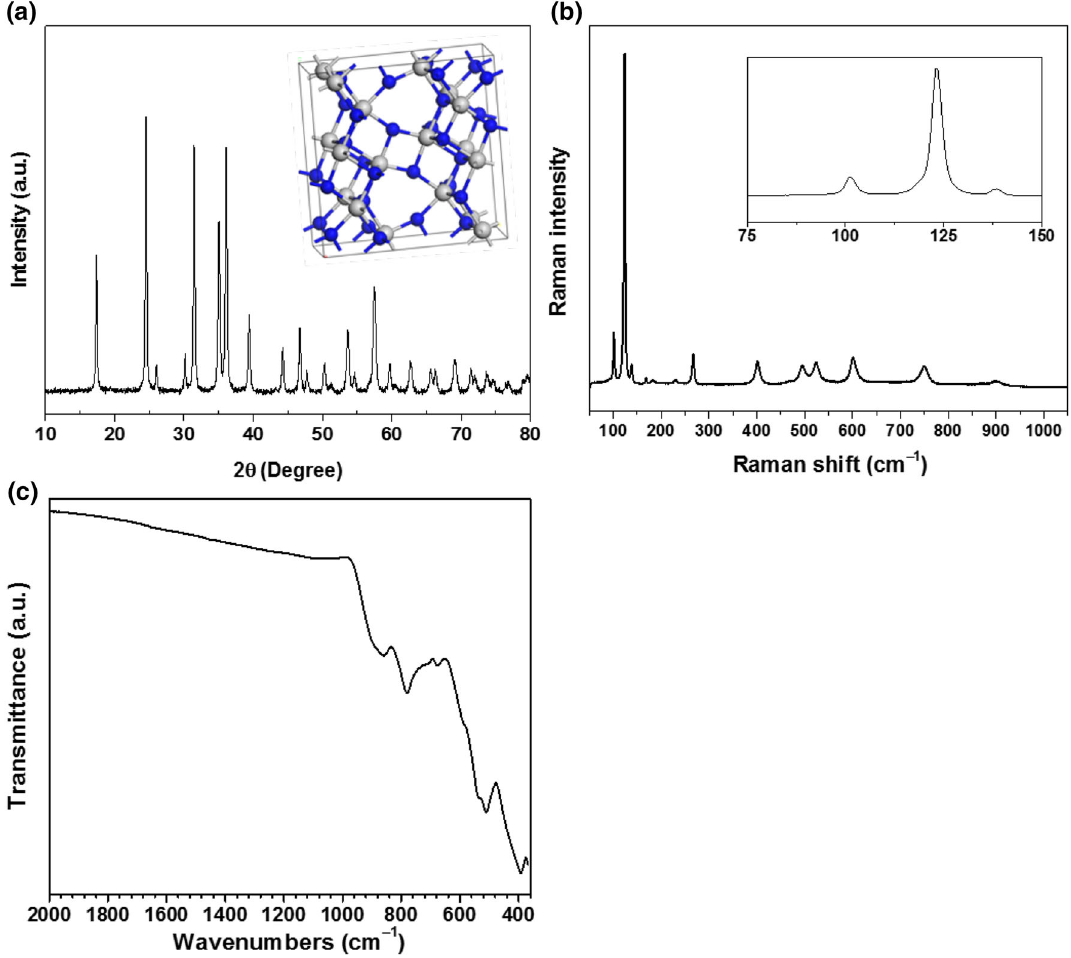
Fig. 3 a XRD pattern and crystal structure ( inset ), b Raman spectra, and c IR spectra of Ta 3 N 5 obtained from nitridation of Ta 2 O 5 by 15 h in NH 3 gas at 900 (cid:3) C. Color legend for crystal structure: Ta in gray and N in blue . All figures are adapted from [64] by permission of